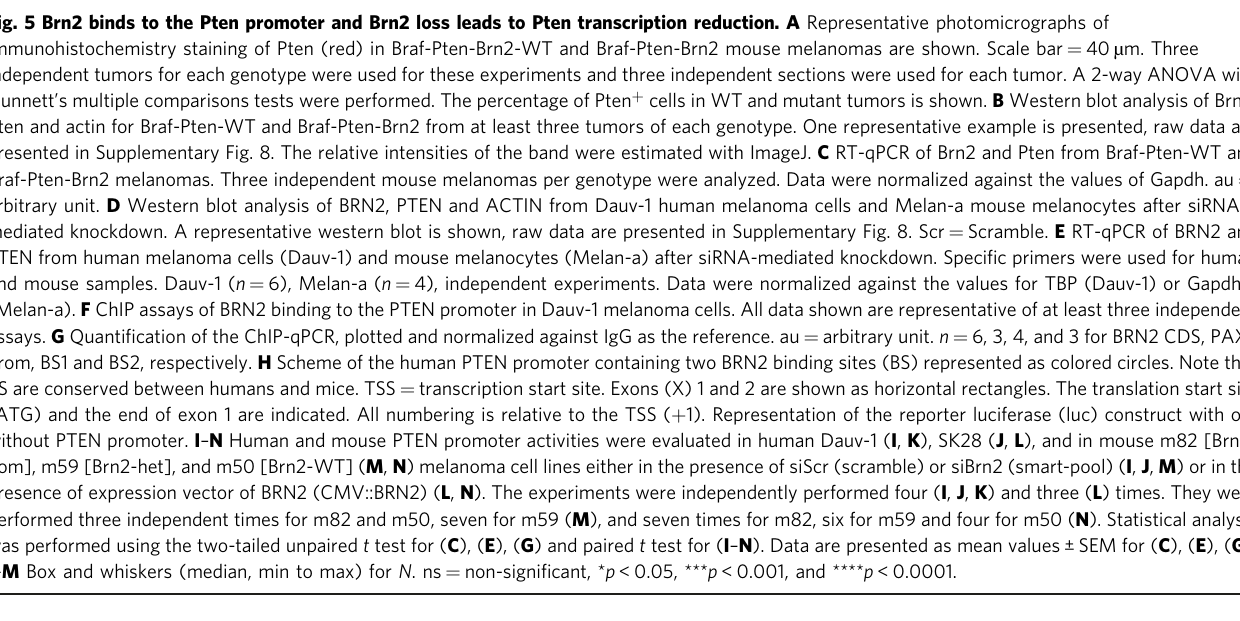
Fig. 5 Brn2 binds to the Pten promoter and Brn2 loss leads to Pten transcription reduction. A Representative photomicrographs of immunohistochemistry staining of Pten (red) in Braf-Pten-Brn2-WT and Braf-Pten-Brn2 mouse melanomas are shown. Scale bar = 40 µ m. Three independent tumors for each genotype were used for these experiments and three independent sections were used for each tumor. A 2-way ANOVA with Dunnett ’ s multiple comparisons tests were performed. The percentage of Pten + cells in WT and mutant tumors is shown. B Western blot analysis of Brn2, Pten and actin for Braf-Pten-WT and Braf-Pten-Brn2 from at least three tumors of each genotype. One representative example is presented, raw data are presented in Supplementary Fig. 8. The relative intensities of the band were estimated with ImageJ. C RT-qPCR of Brn2 and Pten from Braf-Pten-WT and Braf-Pten-Brn2 melanomas. Three independent mouse melanomas per genotype were analyzed. Data were normalized against the values of Gapdh. au